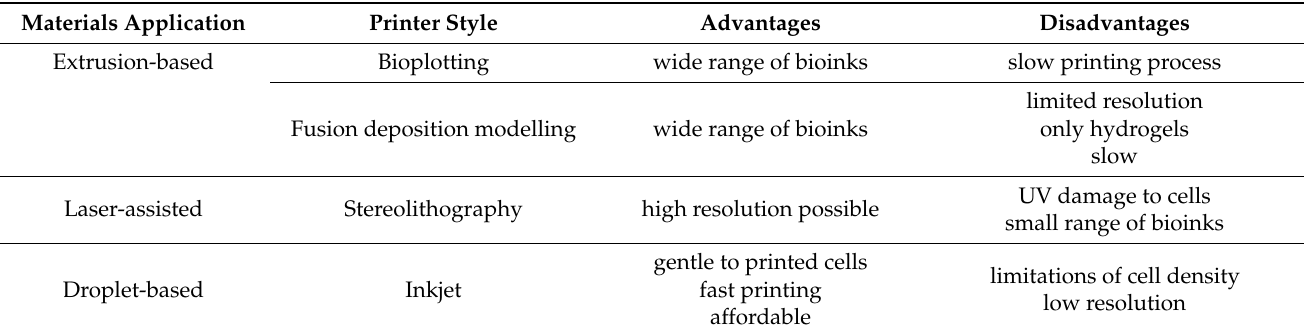
Table 1. Advantages and Disadvantages of the Different 3D Bioprinting